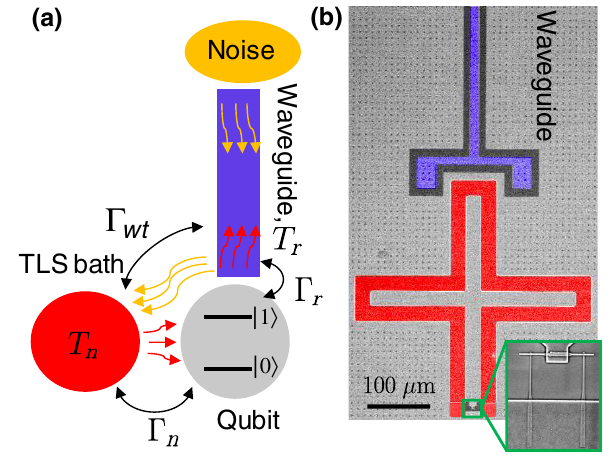
FIG. 1. Sketch of the experimental setup. (a) Schematic show- ing how the two-level artificial atom ( | 0 (cid:3) and | 1 (cid:3) are the corre- sponding ground and excited states of the atom) absorbs energy from the hot TLS bath surrounding the atom, where the hot bath is heated by high-frequency noise from the waveguide with an unknown coupling strength between the bath and the waveguide (cid:6) wt (yellow arrows). Therefore, the excited atom emits photons to the cold waveguide (red arrows). We have (cid:6) r and (cid:6) n as the emission rates of the atom into the waveguide and the nonradiative bath, respectively. (b) False-color micro- graph of the superconducting circuit realizing the setup in (a): a transmon qubit consisting of a cross-shaped superconducting island shunted by a superconducting quantum interference device (SQUID) capacitively coupled to a microwave coplanar waveg- uide (blue). The inset shows a close-up of the SQUID. Further details on the measurement setup are given in Appendix